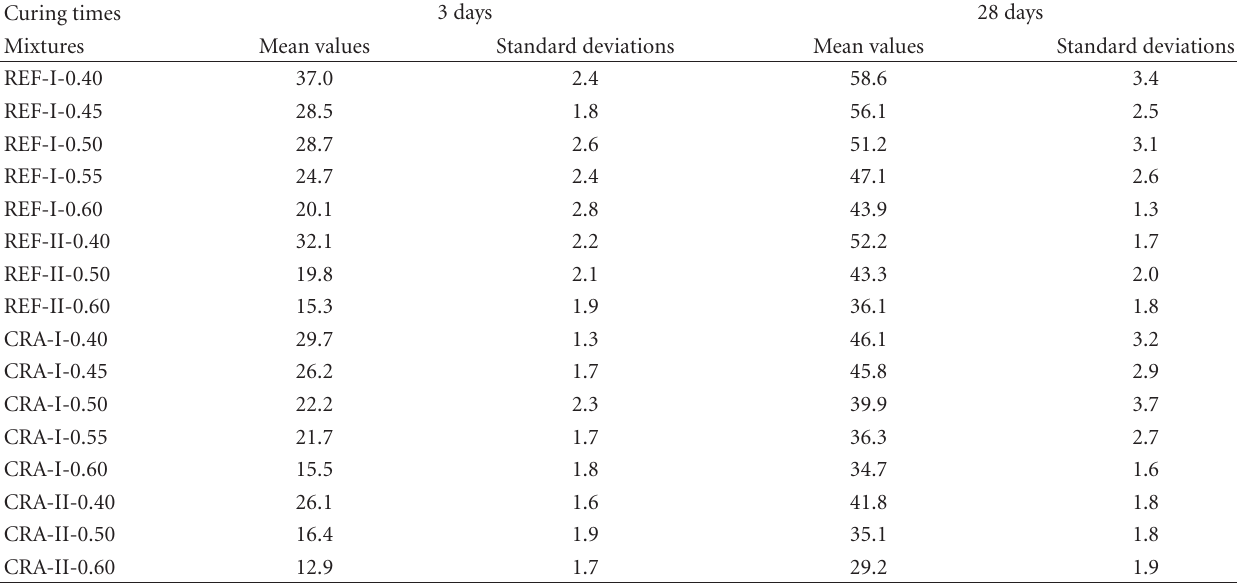
Table 4: Compressive strengths (MPa) after 3 and 28